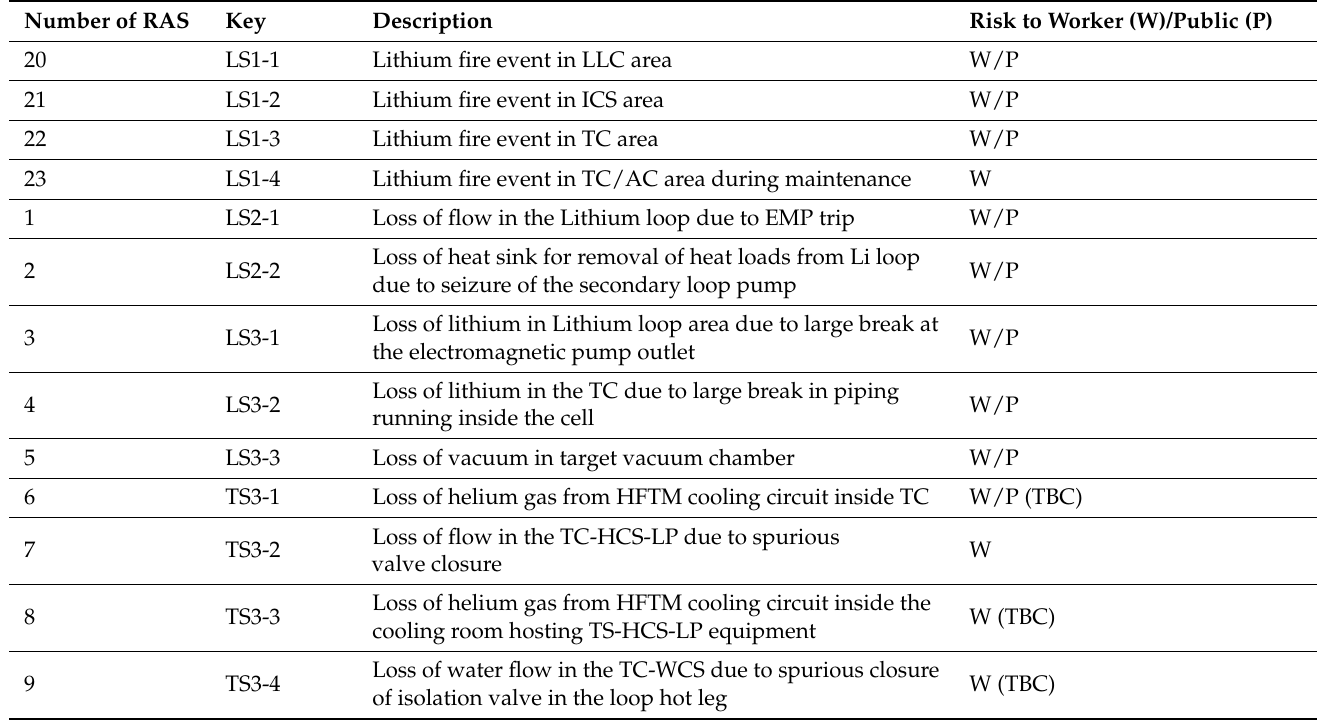
Table 1. List of reference accident scenarios in SAR_v1.0 (TBC means ‘to be confirmed’ as analyses